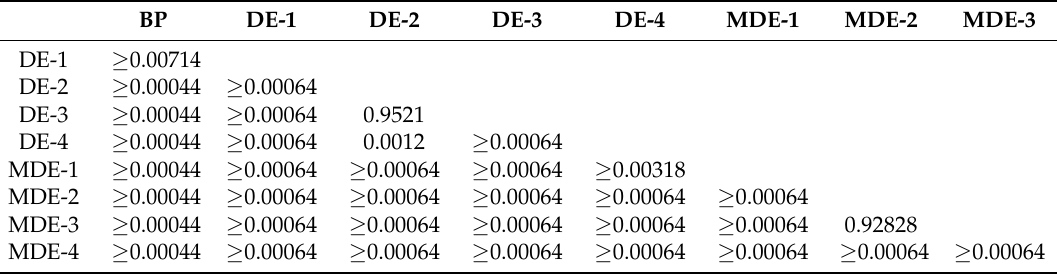
Table 17. Statistical test of results shown in Table